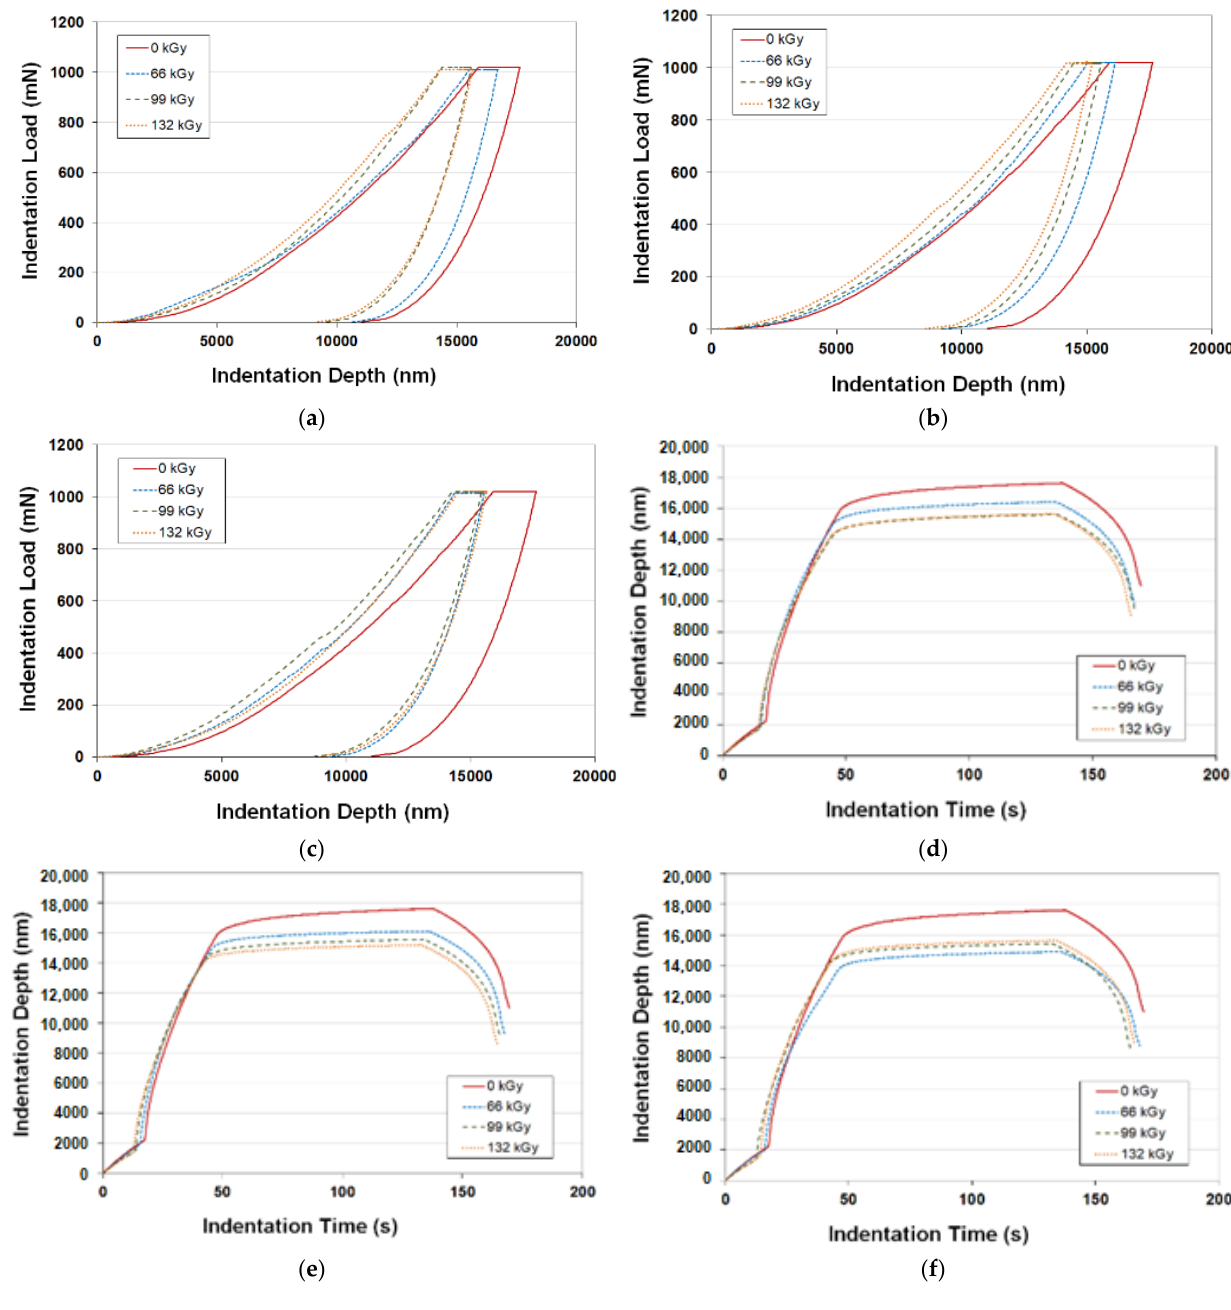
Figure 4. Indentation characteristics: ( a ) indentation force vs. depth of indentation—concentration of TAIC 2%; ( b ) indentation force vs. depth of indentation—concentration of TAIC 4%; ( c ) indentation force vs. depth of indentation—concentration of TAIC 6%; ( d ) depth of indentation vs. time of indentation—concentration of TAIC 2%; ( e ) depth of indentation vs. time of indentation—concentration of TAIC 4%; ( f ) depth of indentation vs. time of indentation—concentration of TAIC 6%.